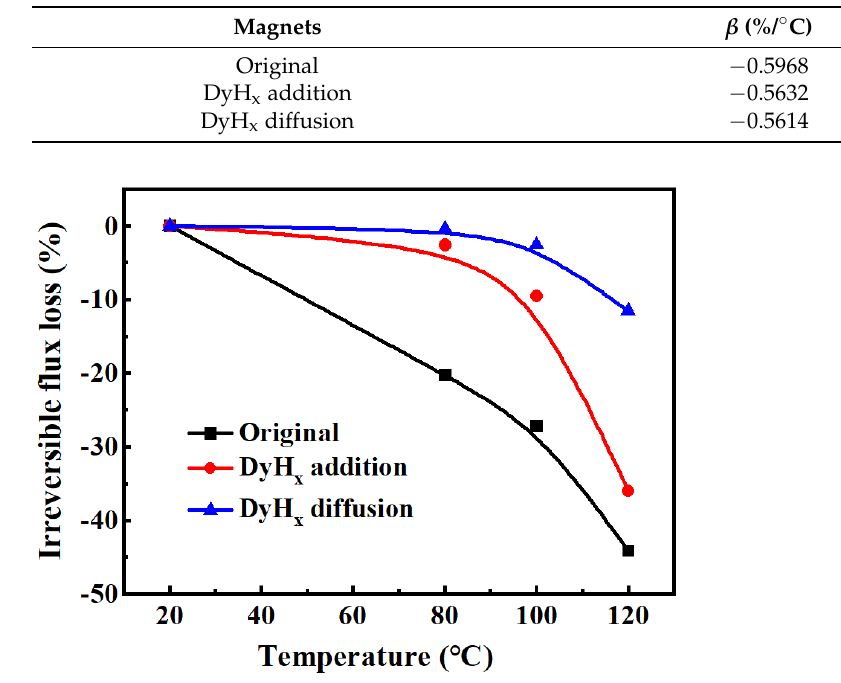
Figure 7. Irreversible loss of flux versus temperature of the original magnet, the DyH x addition mag- net, and the DyH x diffusion